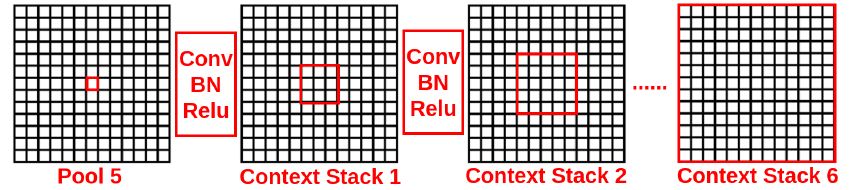
Figure 4. The receptive field (the area of red square) of the context stack is progressively extended to cover all the elements in the feature